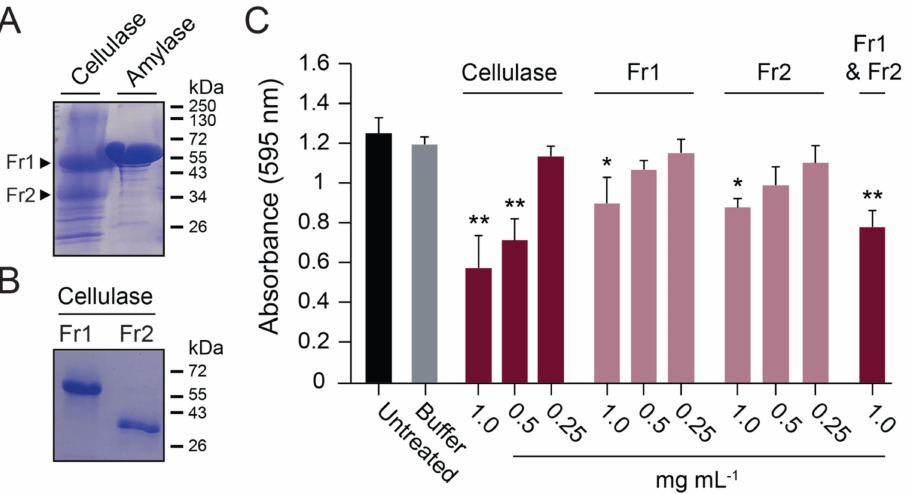
Figure 6. A commercial cellulase preparation contained multiple GHs that disperse biofilms. ( A ) Com- mercial enzyme preparations analyzed by SDS-PAGE with Coomassie blue staining. ( B ) Size exclusion chromatography purification of a glucoamylase (Fr1) and β -xylanase (Fr2) in the commercial cellulase preparation. ( C ) Fr1 and Fr2 activity against S. aureus biofilms grown on polystyrene. Significant differences relative to the buffer control are shown (Tukey’s test, * p < 0.05, ** p < 0.01) ( n =